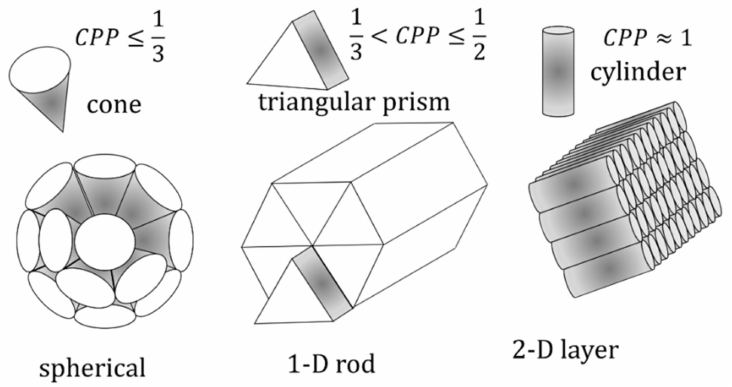
Figure 10. Correlation between the building block shape (quantified by the critical packing parameter) and the shape of the